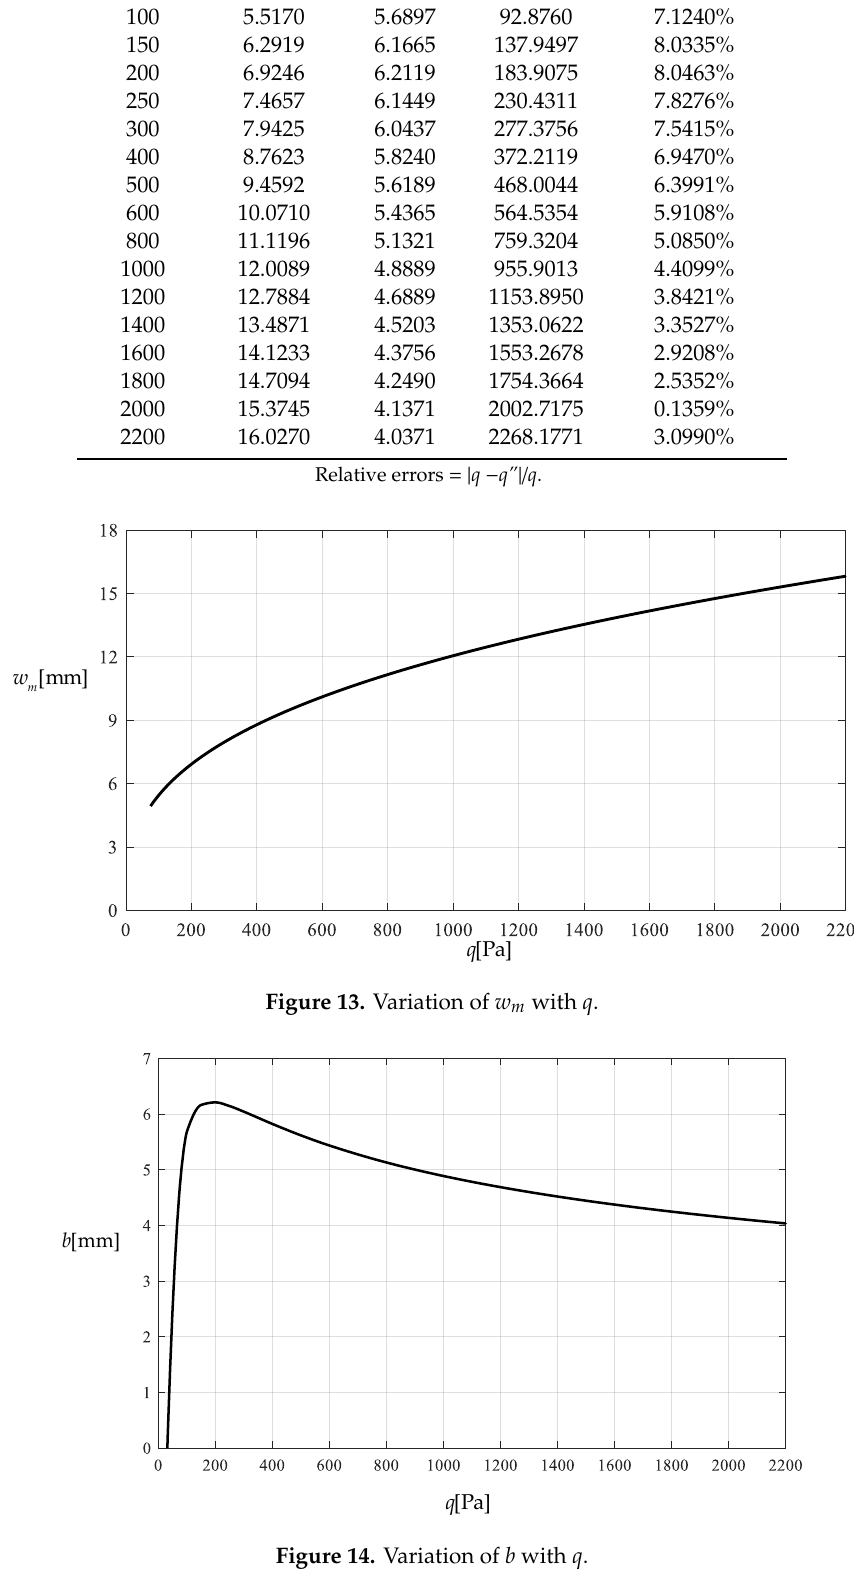
Figure 15. Variations of q with m w .